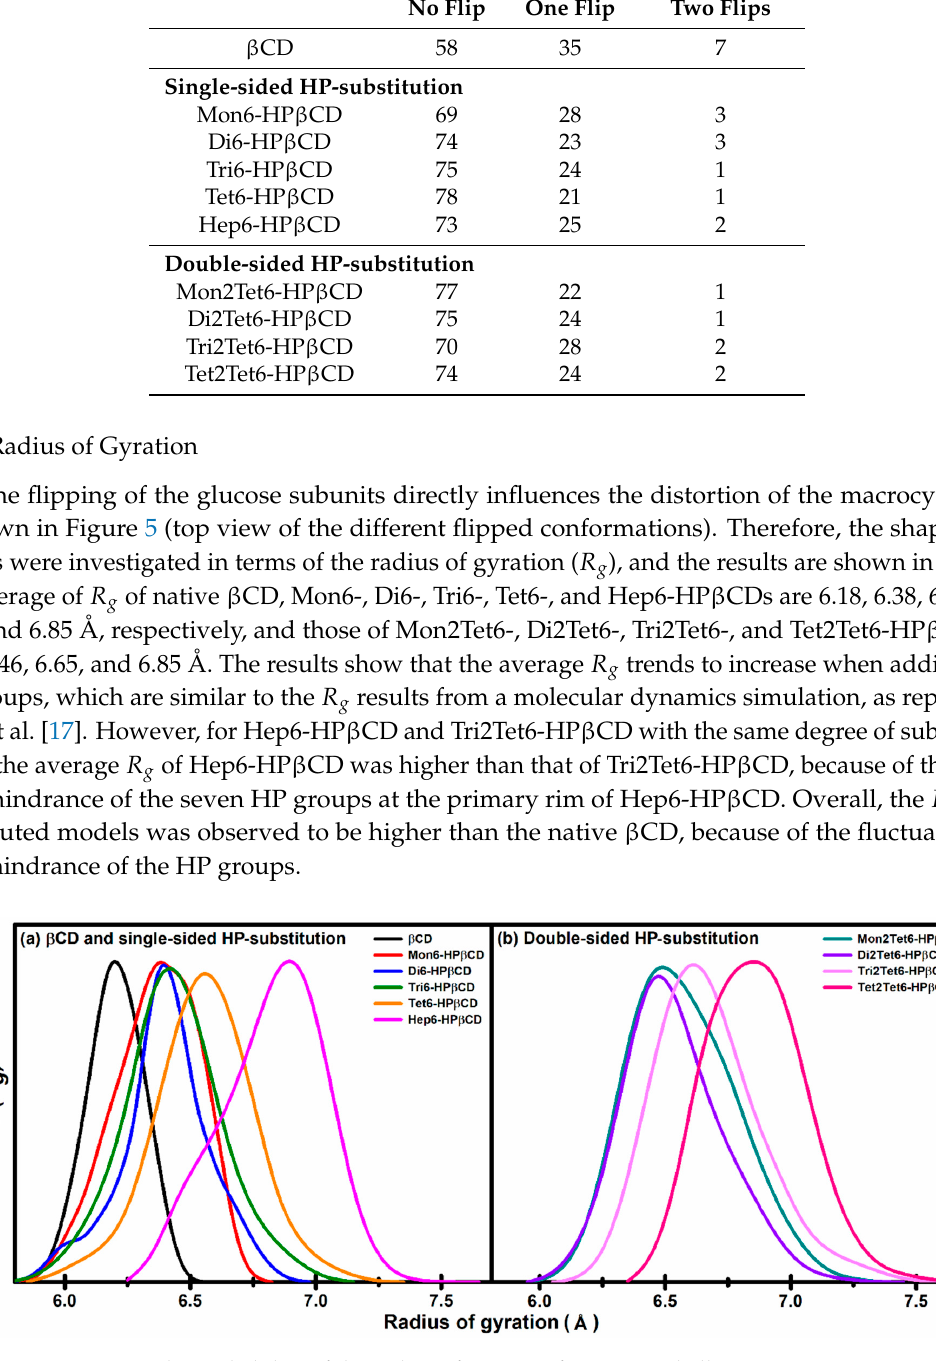
Figure 6. The probability of the radius of gyration for β CD and all HP β CDs at 300K.